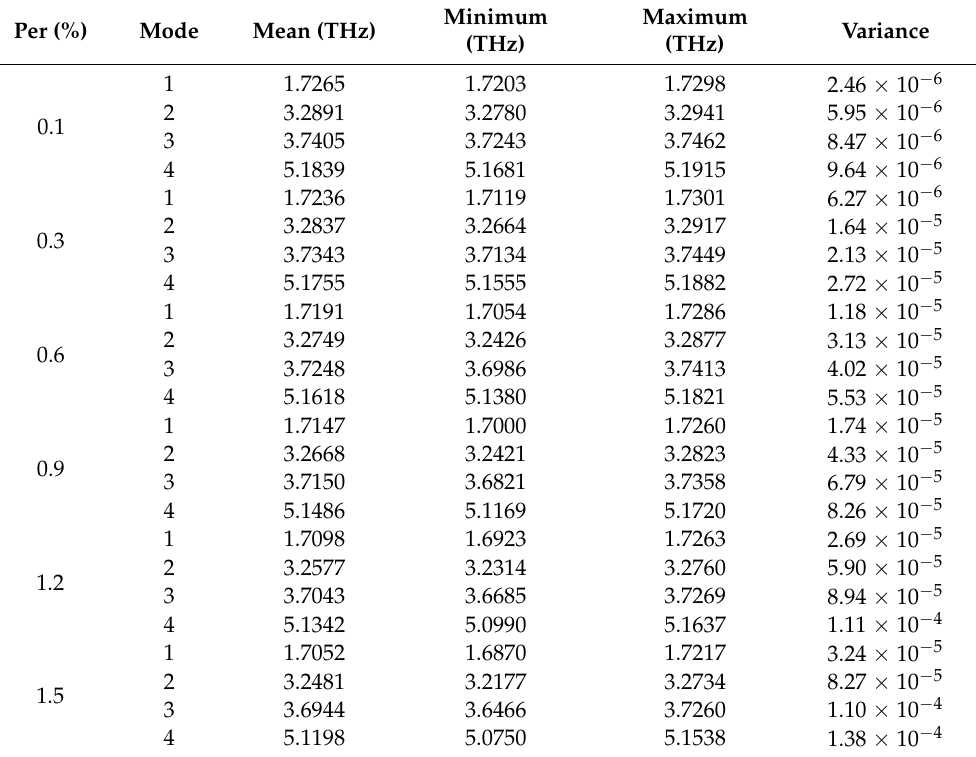
Table 1. Statistical results of resonant frequencies for porous graphene with atomic vacancy